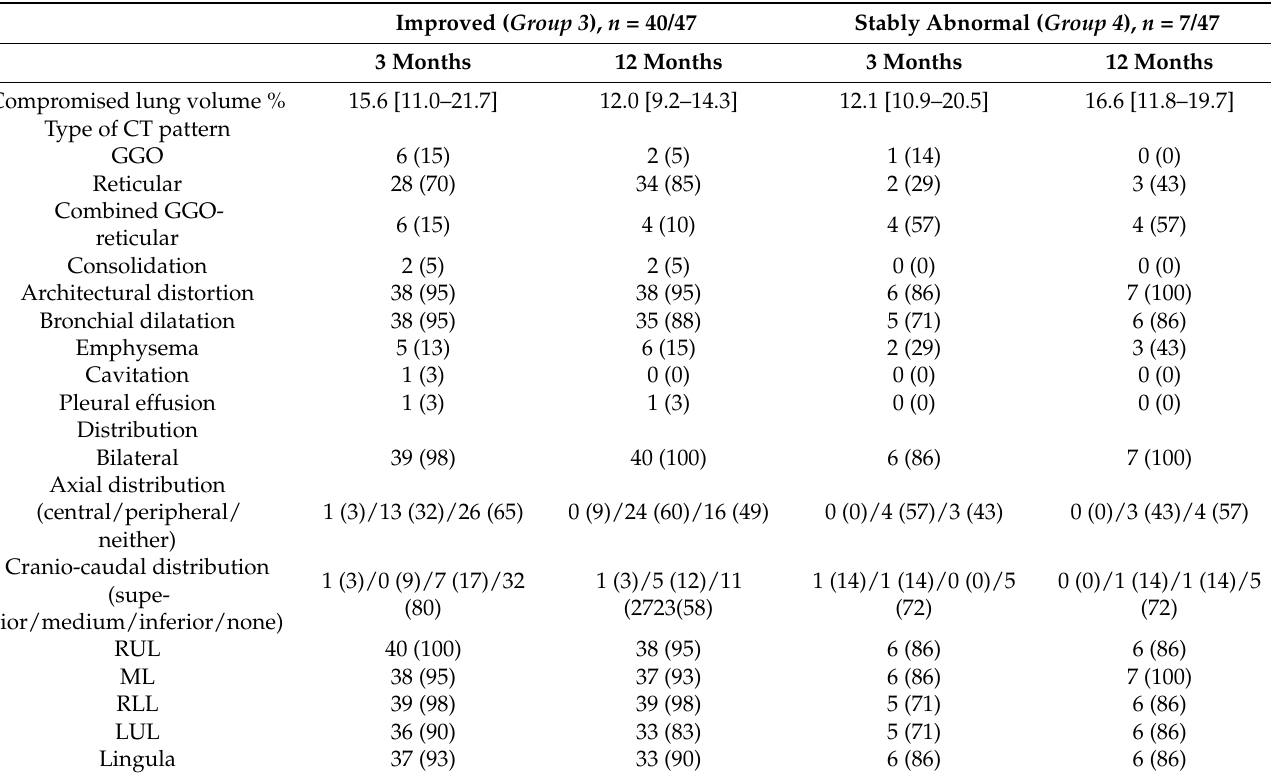
Figure 3. Unenhanced chest CT scan axial images of the same patient in Figure 2 ( group 3 ) at 3 ( a ) and 12 months ( b ) after discharge. An overall improvement is evident, with previous GGO (grey arrowheads, ( a )) almost resolved but showing a “ melting sugar ” appearance on the latter (empty arrowheads, ( b )). Reticular opacities (white arrowheads, ( a , b )) also improved but remained evident; the black arrowhead ( b ) highlights a new onset of tiny peripheral reticular opacification. Persistent architectural distortion, bronchial dilation, and predominant peripheral axial distribution were noted, with no significant differences among the two CT sets. Cranio-caudal distribution turned statistically significant ( p = 0.047; Table 3). Table 4 shows radiological findings over time in patients with improved ( group 3 ) vs. stably abnormal ( group 4 ) chest CT. Table 4. Radiological findings in 47 COVID-19 survivors * with an abnormal chest CT scan at 12 months after discharge, divided into improved ( group 3 ) vs. stably abnormal ( group 4 ), based on radiological finding trend (as described in the Section 2.2).